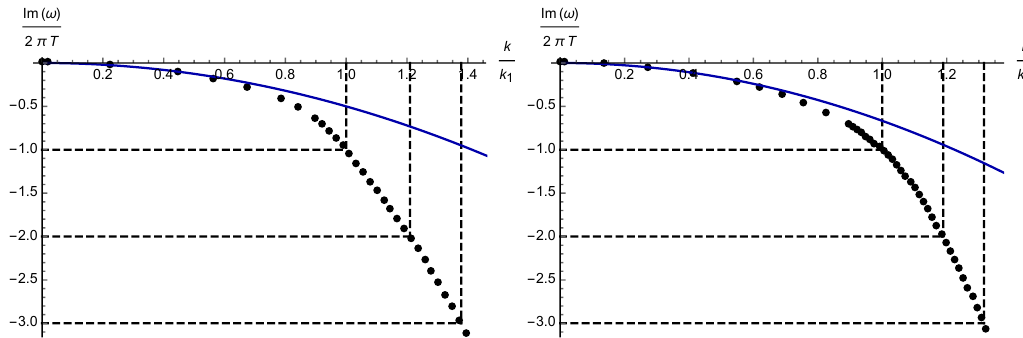
Figure 3 . Dispersion relation of the charge di(cid:11)usion mode from AdS 5 -Schwarzschild (left) and of the momentum di(cid:11)usion mode from AdS 4 -Schwarzschild (right). Black dots show the exact dispersion relation determined by numerical integration of the appropriate perturbation equations in ( t; r ) coordinates, solid blue lines show the di(cid:11)usive hydrodynamic dispersion relations ((5.3) and (5.11) respectively), and the intersections of the black dashed lines correspond to the (real k ) pole-skipping points ((5.6) and (5.12) respectively). The short-distance corrections to di(cid:11)usive hydrodynamics are such that the pole passes through a succession of pole-skipping